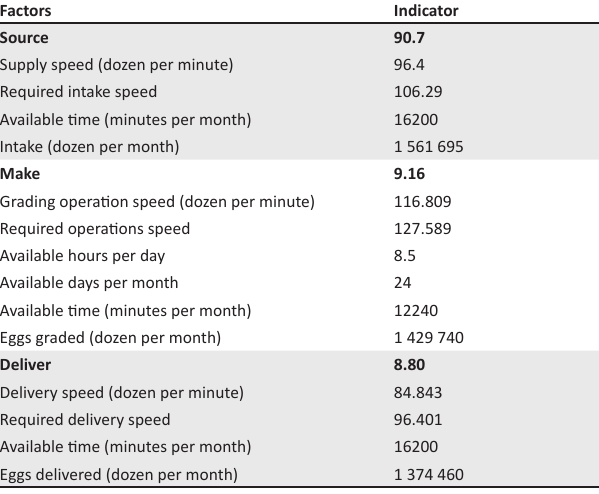
TABLE 14: Developed model: responsiveness leg.